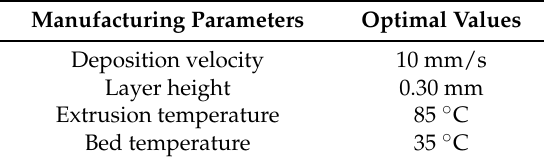
Table 3. Manufacturing parameters and the corresponding optimized values.